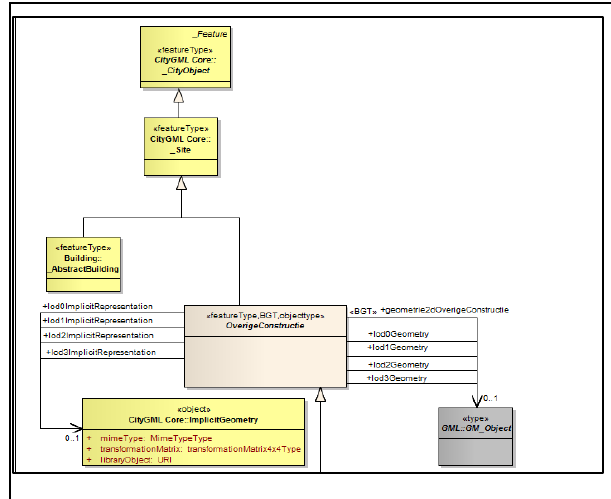
Figure 2: OverigeConstructie, new class added, derived from _Site